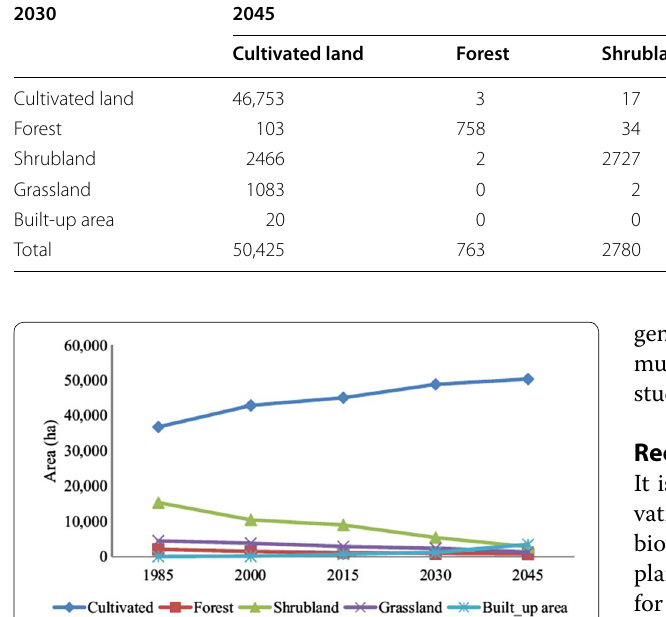
Fig. 6 Trends of land use/land cover changes from 1985 to 2045 in the Andassa